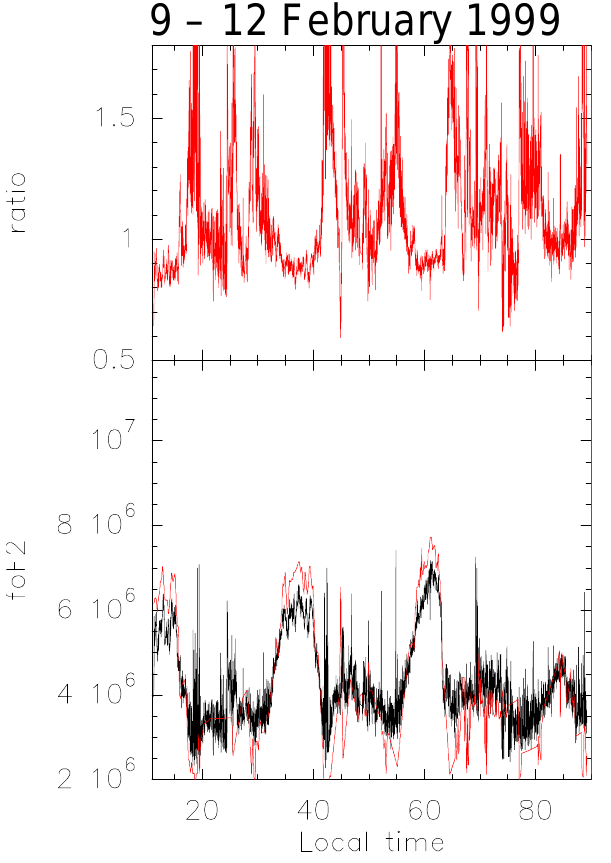
Fig. 6. fo F2 comparison between the IS radar data in black and the Dynasonde